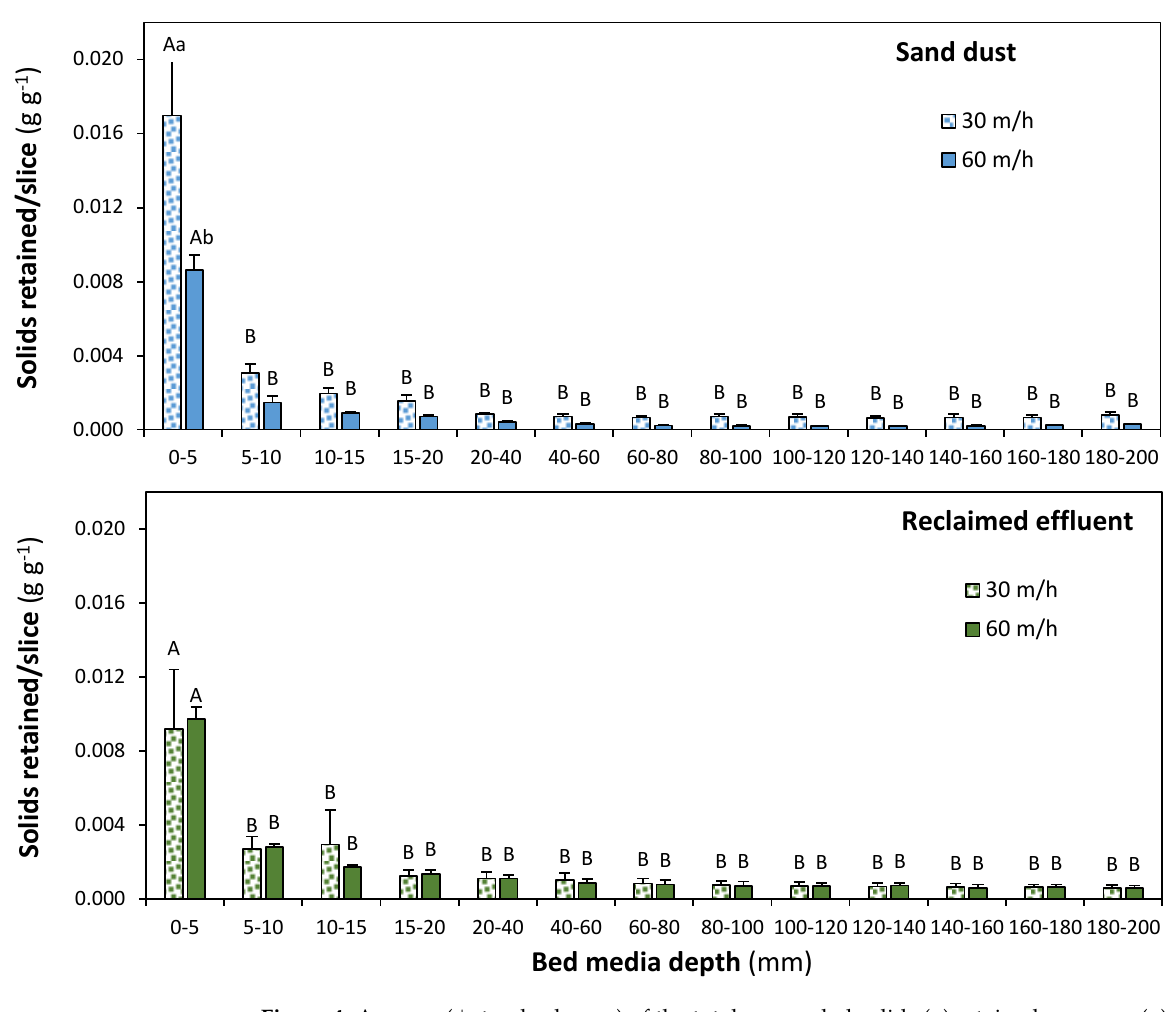
Figure 4. Average ( ± standard error) of the total suspended solids (g) retained per mass (g) of slice bed across the whole media bed depth regarding the type of particles added and the target filtration velocity. Different small letters show significant differences ( p < 0.05) between filtration velocities for a given bed depth. Different capital letters show significant differences ( p < 0.05) between media bed depths for a given filtration velocity.